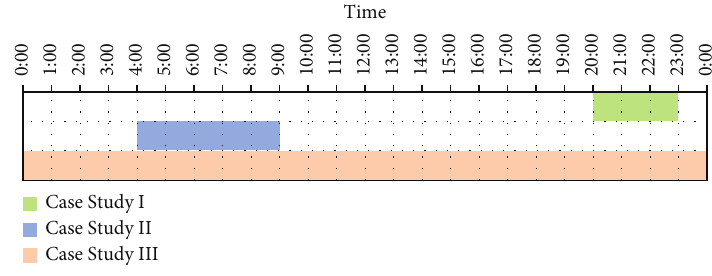
Figure 9: Timing of pothole patching actions. Table 10: Feature importance scores from RF